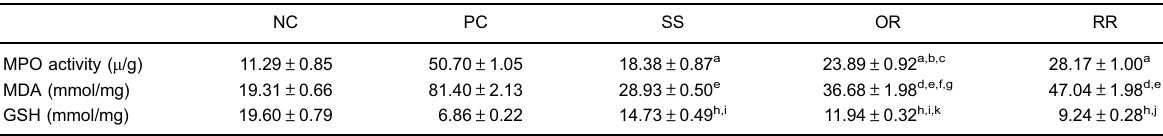
Table 2. The effects of ro fl umilast on colonic levels of MPO, MDA, and GSH in rats with trinitrobenzenesulfonic acid (TNBS)-induced colitis